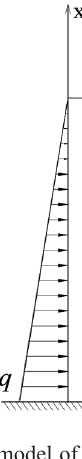
Fig. 9. Mechanical model of cantilever pile with triangular distribution